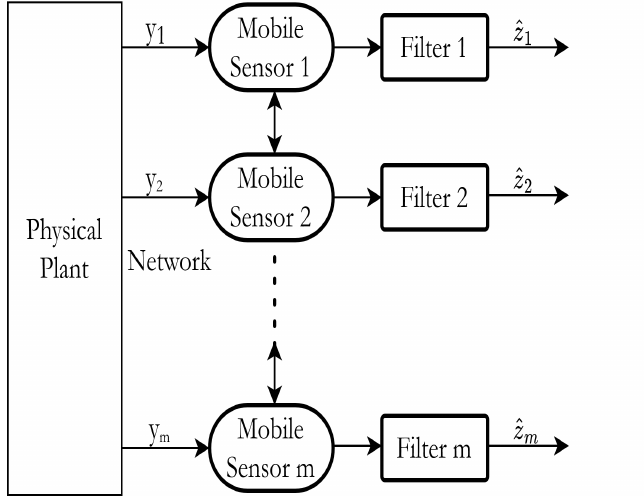
Figure 1. The filtering issue in mobile sensor